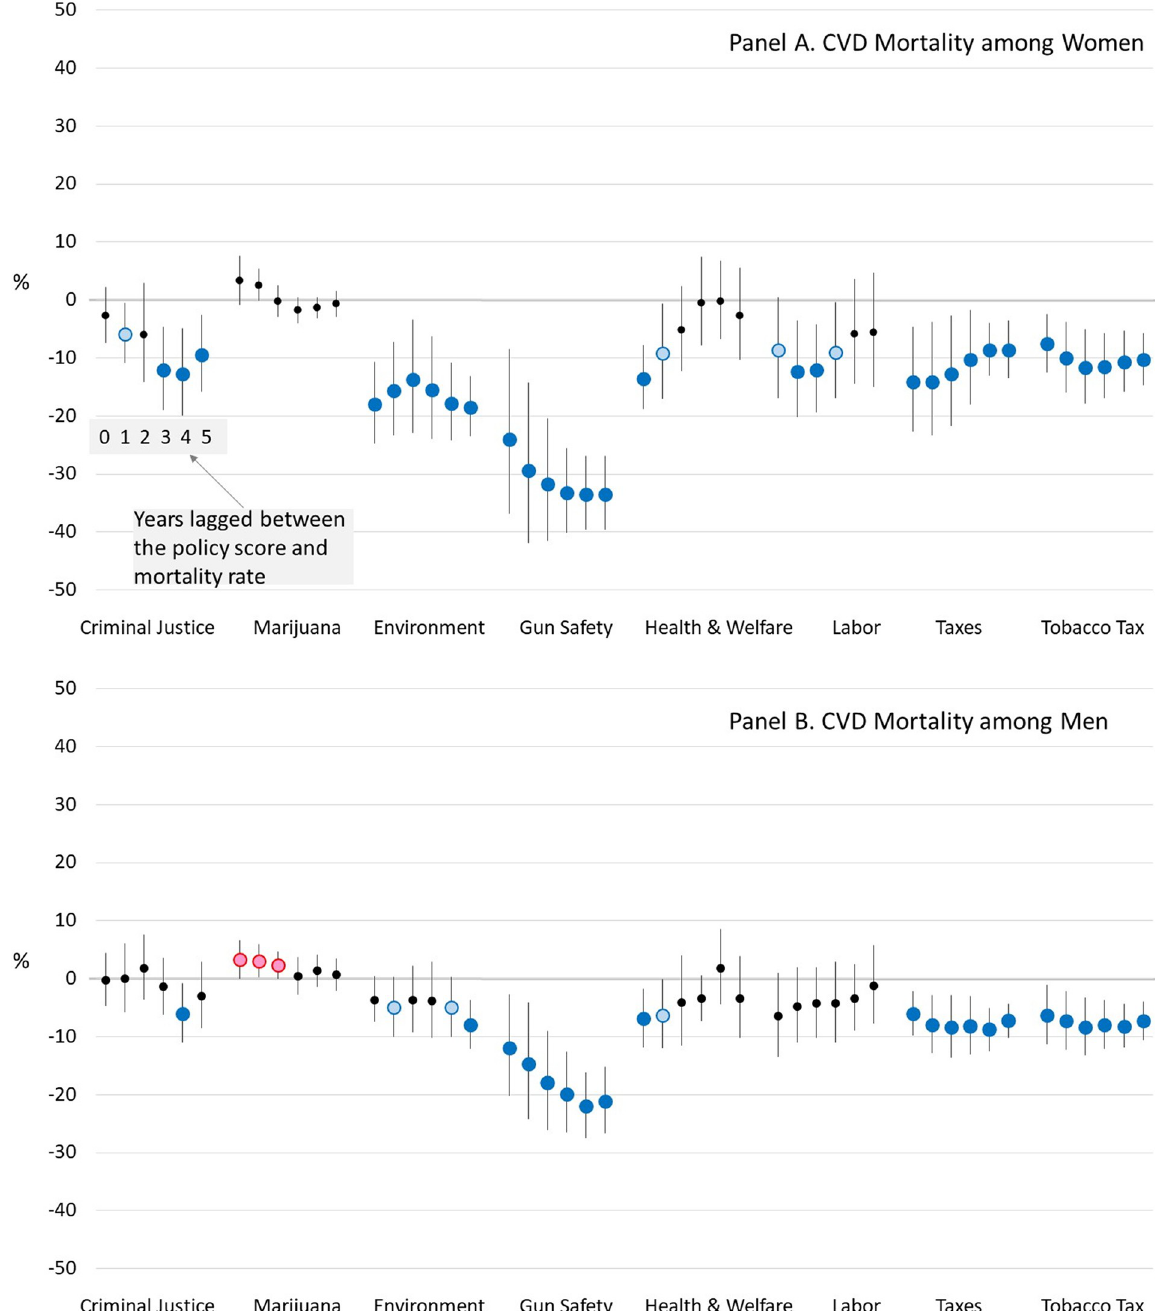
Fig 3. Estimated percent difference in cardiovascular mortality rates when a U.S. State’s policy liberalism score is 1 versus 0, for various lag times between the policies and mortality. Notes : Blue dots mean a more liberal version of the policy is associated with lower mortality and red dots mean a more conservative version is associated with lower mortality. Dark blue and red dots indicate that the association is significant at α < 0.05, while light blue and red dots indicate that it is significant at α < 0.10.